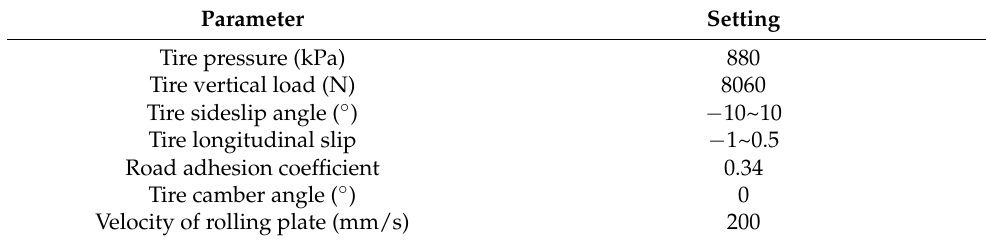
Figure 2. Bench test scenario of the tire mechanical properties. Table 1. Bench test scenario of the tire mechanical